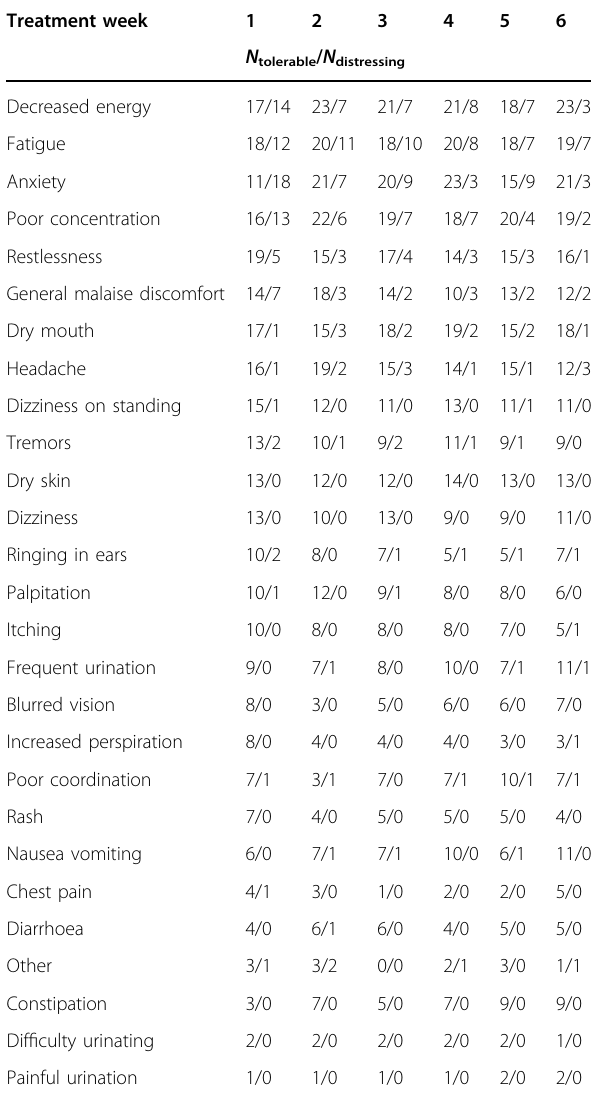
Table 3 Patient Rated Inventory of Side Effects (PRISE) counts of symptoms (rated tolerable or distressing) 60 mins post oral ketamine administration by treatment week ( n =